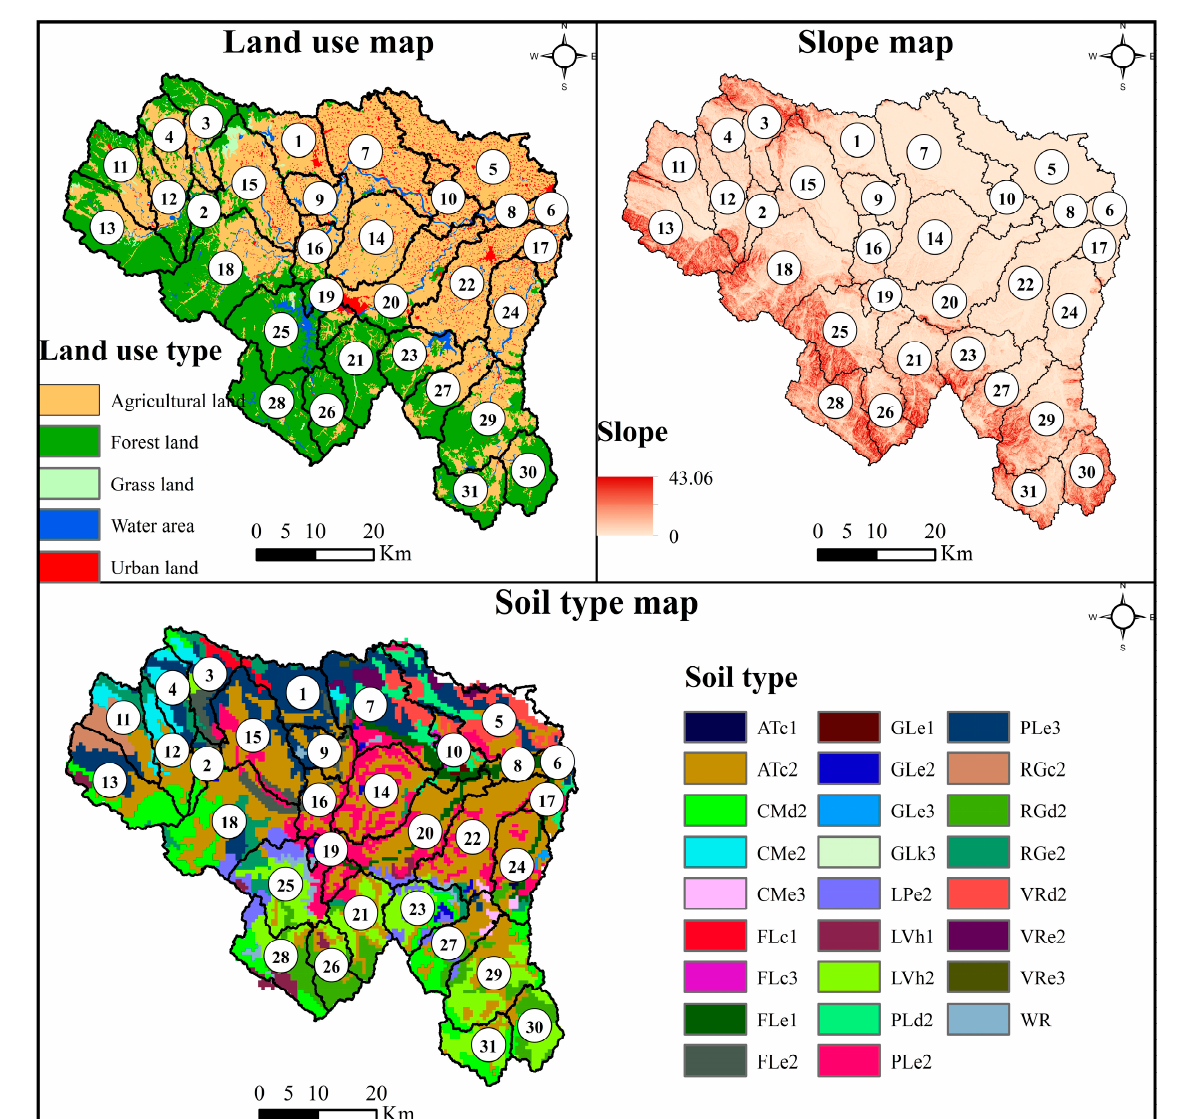
Figure 3. Distribution of land use, slope, and soil type within the XXW. Numbers (1–31) with circles indicate subwatershed numbers. The number after the soil type code indicates the soil texture. “ATc”, “CMd”, “CMe”, “FLc”, “Fle”, “Gle”, “GLk”, “LPe”, “LVh”, “PLd”, “PLe”, “RGc”, “RGd”, “RGe”, “VRd”, “VRe”, and “WR” represent cumulic anthrosols, dystric cambisols, eutric cambisols, calcaric fluvisols, eutric fluvisols, eutric gleysols, calcic gleysols, eutric leptosols, haplic luvisols, dystric planosols, eutric planosols, calcaric regosols, dystric regosols, eutric regosols, dystric vertisols, eutric vertisols, and water bodies,